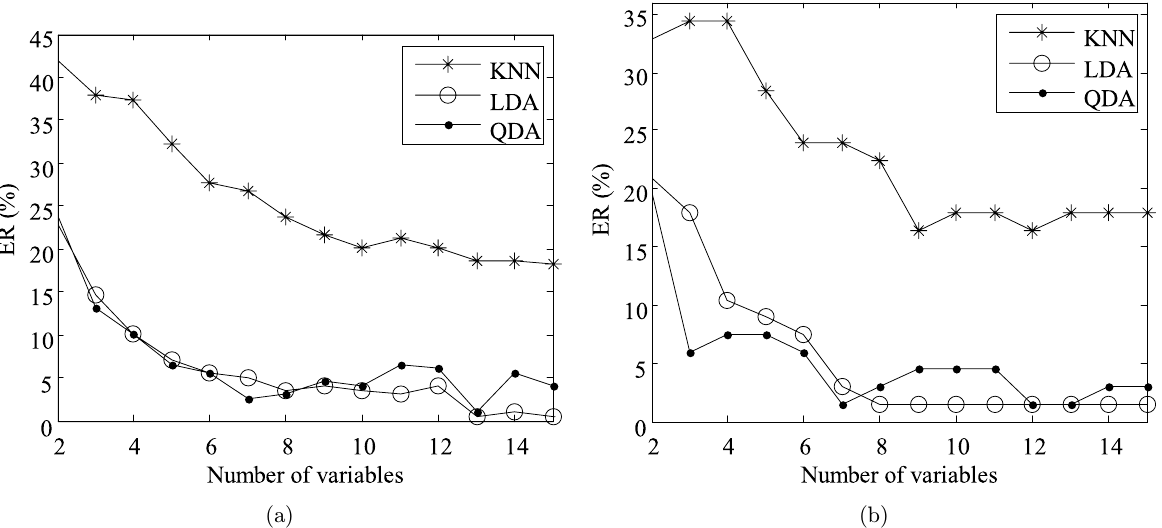
Fig. 3. The curves of total classi¯cation error versus retained variables for KNN, LDA and QDA methods: (a) Cross-validation and (b)